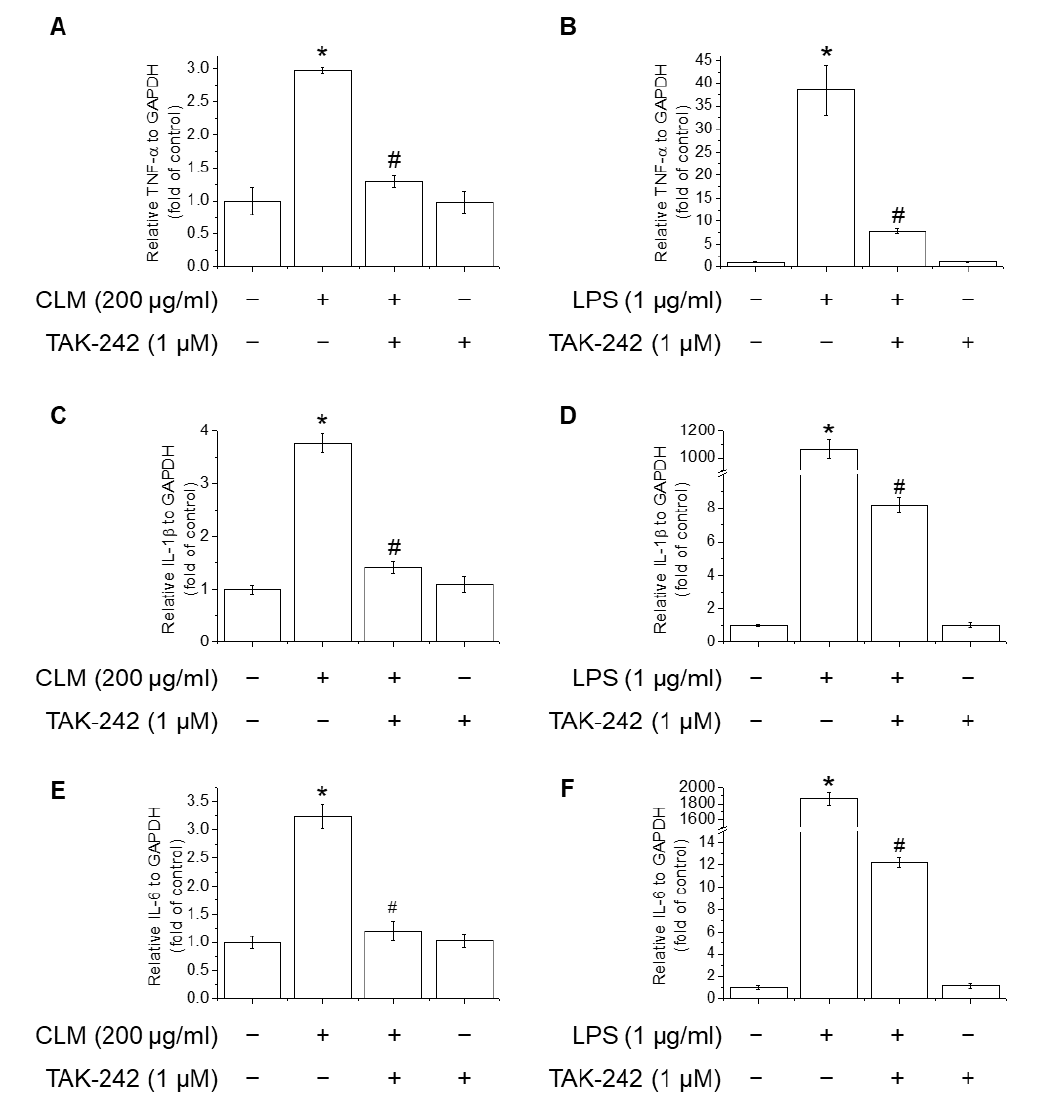
Figure 8. Effect of TLR4 inhibitor on CLM induced TNF- α , IL-1 β , and IL-6 production in RAW264.7 cells. Cells were preincubated with 1 μ M TAK-242 for 1 h, followed by incubation with 200 μ g/mL CLM or 1 μ g/mL LPS for 6 h. mRNA levels of TNF- α ( A , B ), IL-1 β ( C , D ), and IL-6 ( E , F ) were measured by RT-PCR. * p < 0.01 vs. control group; # p < 0.01 vs. CLM-treated group.